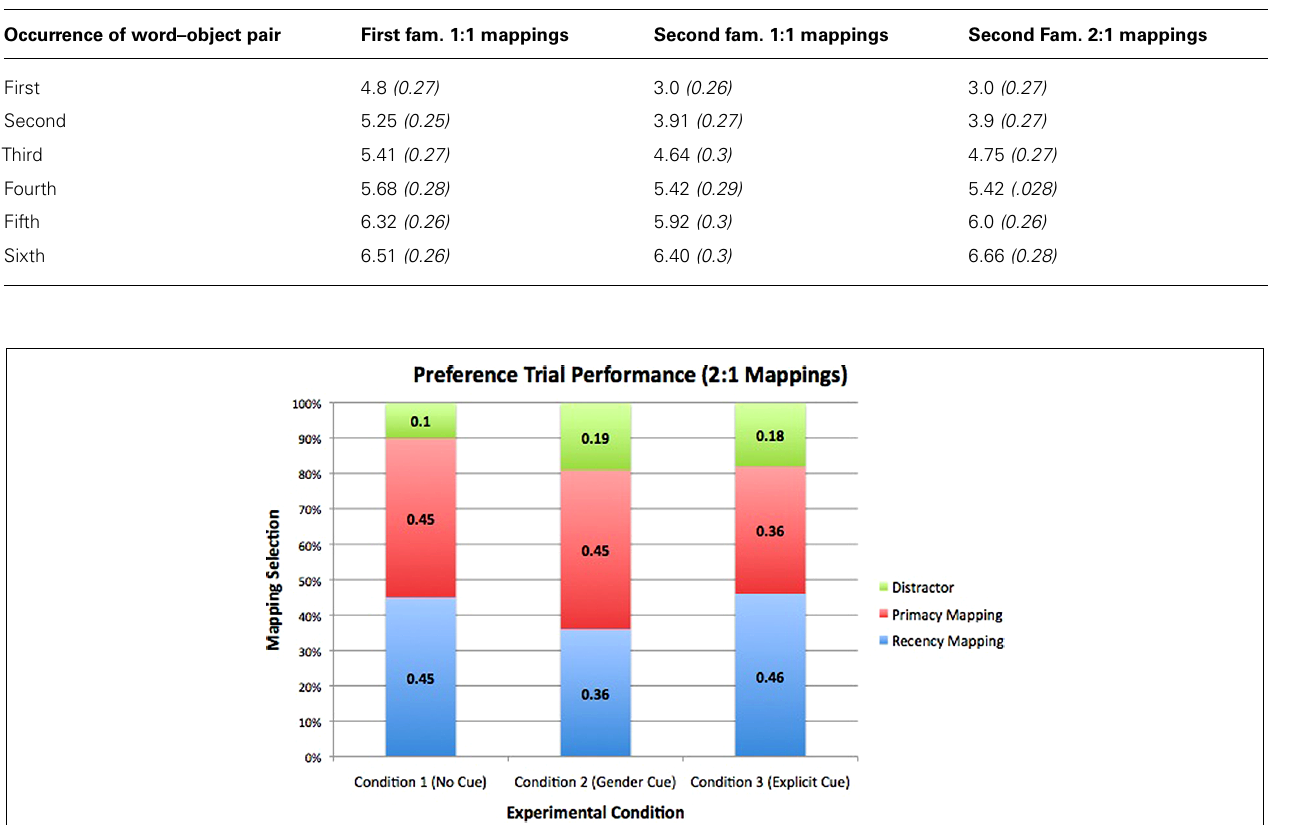
FIGURE 3 | Preference data collected from test trials in which participants saw both the primacy and recency mapping of a word, along with two distractor objects. Within each of the three conditions, participants showed no significant preference for primacy or recency